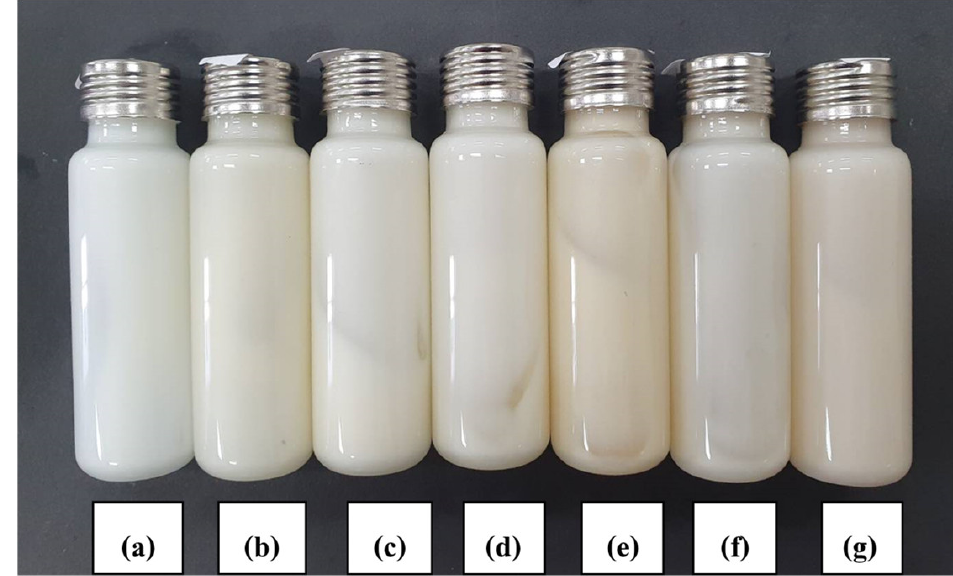
Figure 4. Deodorant cream with 1.5% H-CMCH by heating/cooling cycle; ( a ) cycle 0, ( b ) cycle 1, ( c ) cycle 2, ( d ) cycle 3, ( e ) cycle 4, ( f ) cycle 5, and ( g ) cycle 6.